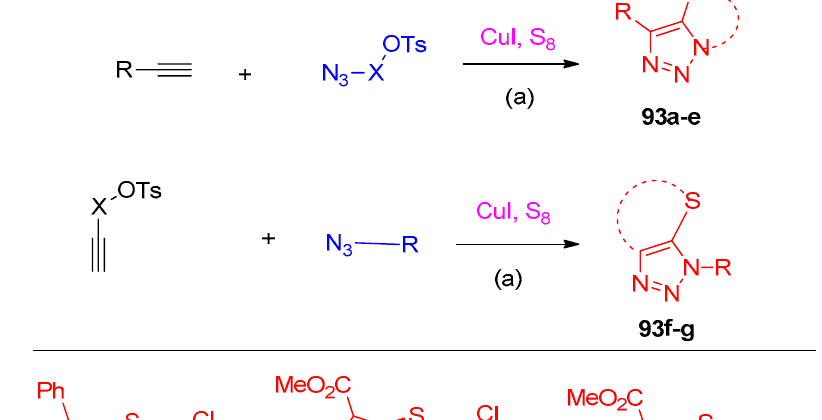
a halide forms II, transformed into copper(II) thiolate IV via reductive organic group transfer and oxidation. The cycloaddition of VI with the azide produced the copper(I) triazolide intermediate VI1 . Reaction of copper(II) thiolate IV with the copper(I) triazolide would give the intermediate V . Finally, reductive elimination of V would then lead to the expected 5-thiotriazole 89a − u (Scheme 47) [34].